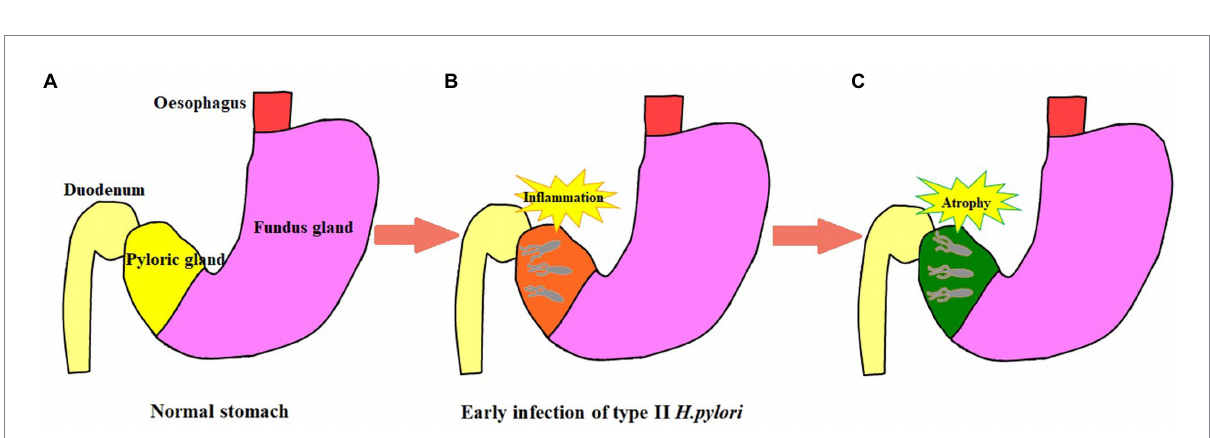
FIGURE 6 Schematic diagram of type II H. pylori infection. (A) Normal stomach structure. (B) The initial stage of type II H. pylori infection is limited to the gastric antrum. (C) Type II H. pylori infection in gastric antrum progresses to atrophy and it is difficult to advance to the stomach